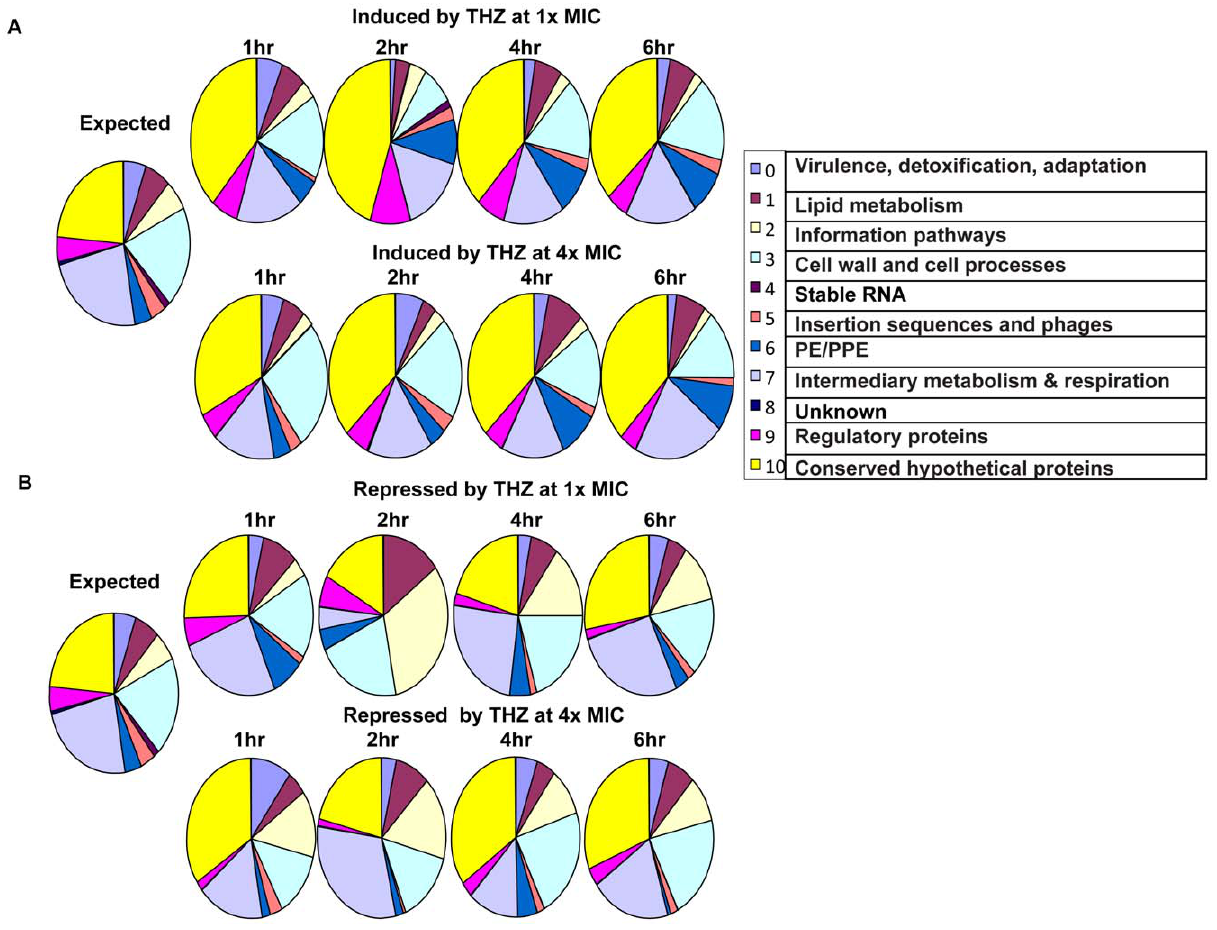
Figure 1. Functional categorization of the global induction (A) or repression (B) in Mtb gene-expression following 1x (top panel in both A and B) or 4x THZ (bottom panel in both A and B) treatment is shown as a series of pie charts. The first (leftmost) pie corresponds to an expected distribution of the various functional categories into which the Mtb genes are represented based on the total number of genes corresponding to each category. The number of genes from each functional category, whose expression was perturbed in individual THZ treatment experiments, is represented in the subsequent pies. The first functional category (0=Virulence and detoxification) begins at 12 O Clock in very pie and the subsequent categories are represented in a clock-wise direction.